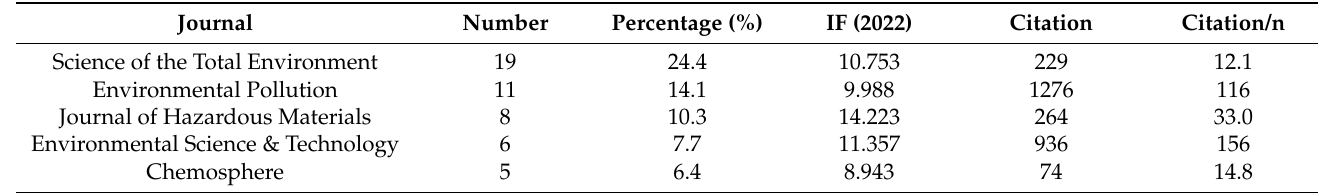
Table 1. Top five journals in the field of micro(nano)plastic toxicity to